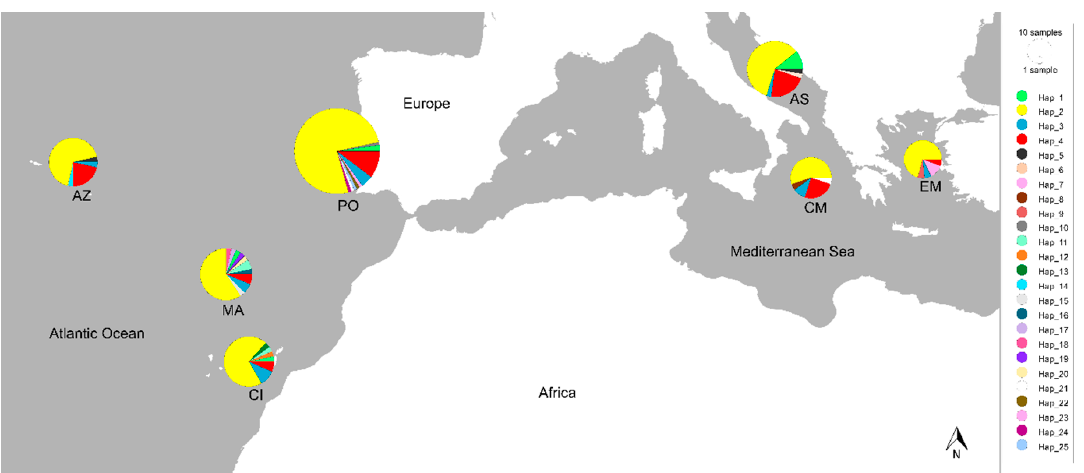
Table 2. Length–length regression parameters (a,b) and determination coefficient (r 2 ) of blue jack